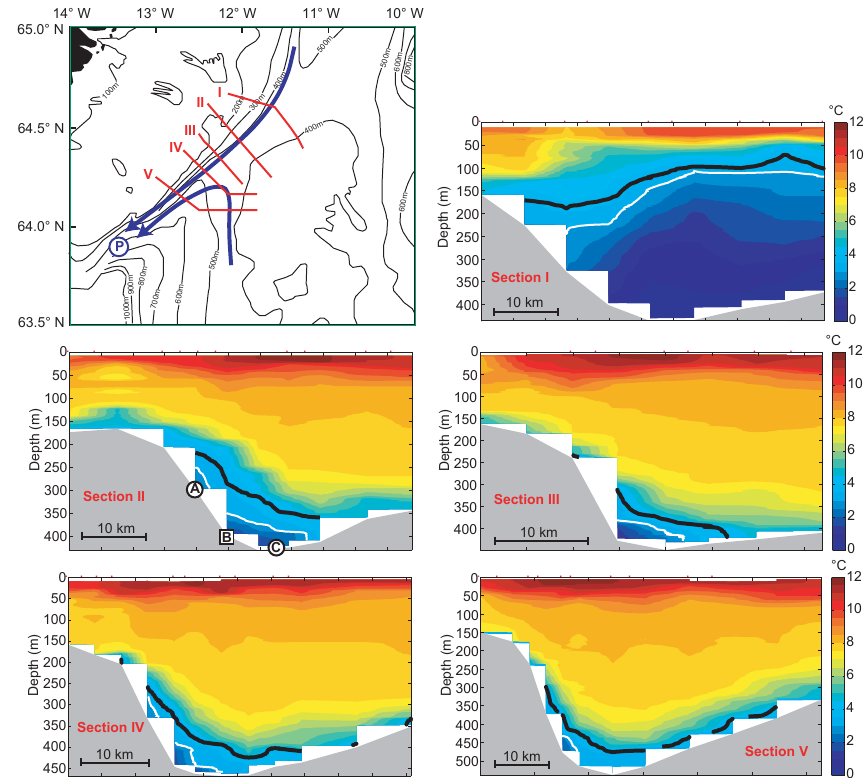
Figure 10. Station map and potential temperature (background colour) along five sections (I to V) crossing the WV, acquired by R/V Poseidon in August 2016. The thick black lines indicate the σ θ = 27 . 8kgm − 3 isopycnal. The white lines indicate the 3 ◦ C isotherm. Vertical and horizontal scales vary between sections, but the temperature (colour) scales are identical. The moorings of the field experiment were deployed along section II and are shown at the bottom of that section. The blue arrows on the map indicate likely cold-water flow paths, and the blue circle labelled P on the map marks mooring site